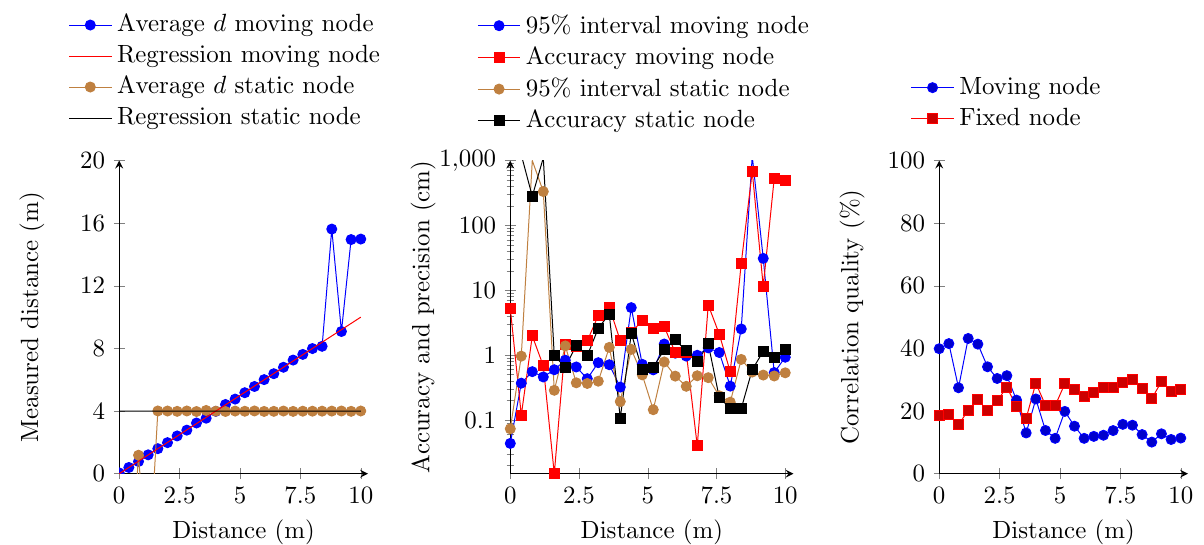
Figure 17. Linear regression of the measured distances ( left ); accuracy and the 95% confidence interval ( middle ); and correlation quality ( right ). In these measurements, the amplitude of the transmitters equals 3.3 V and is put into a multiple access